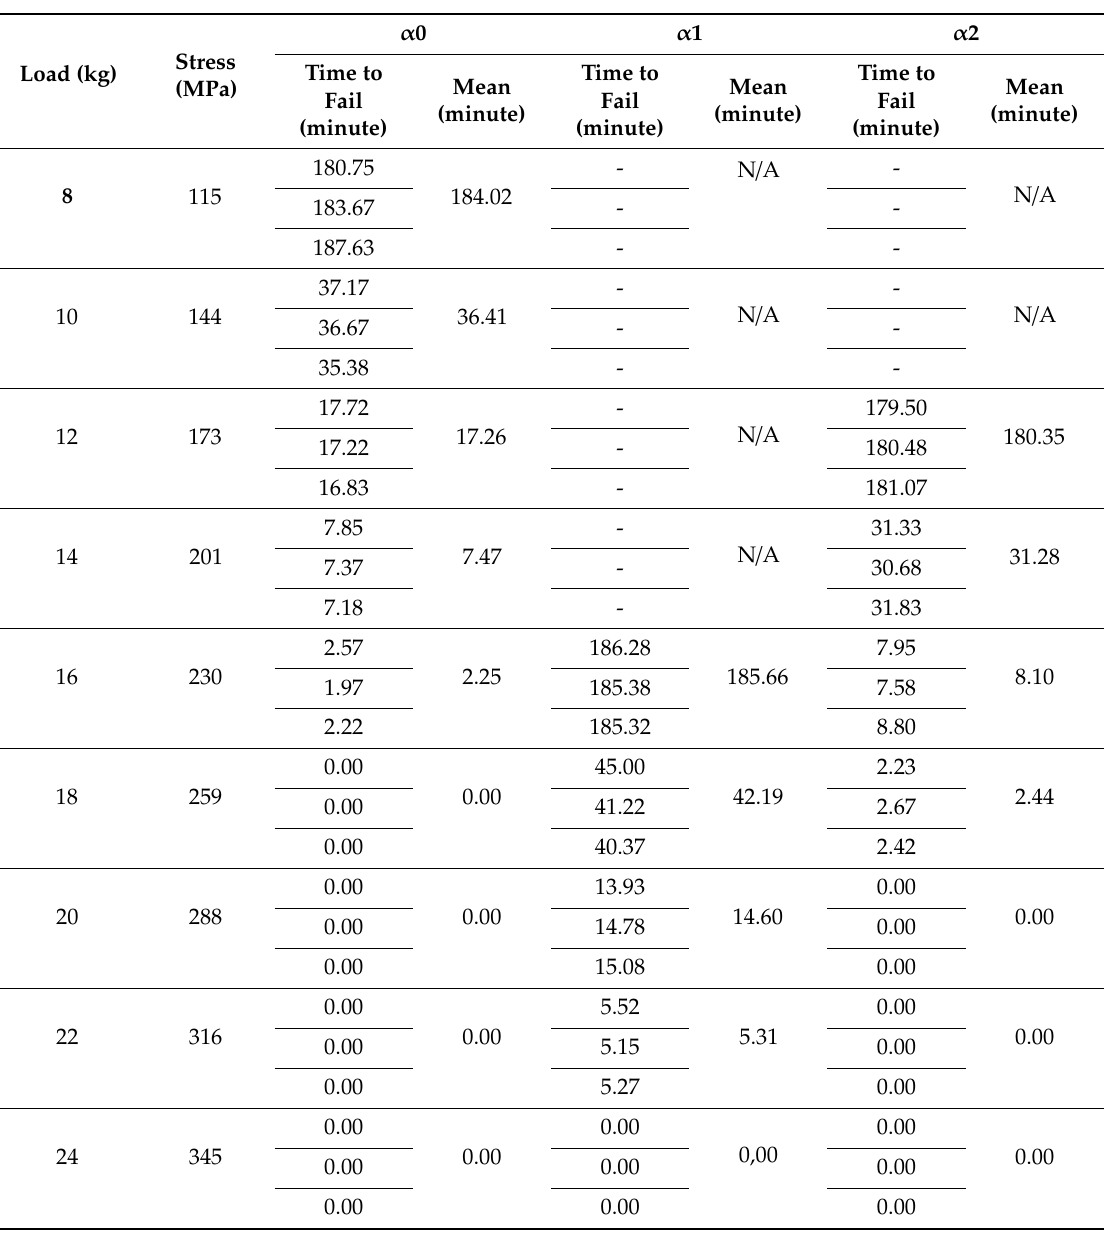
Table 3. SCC test